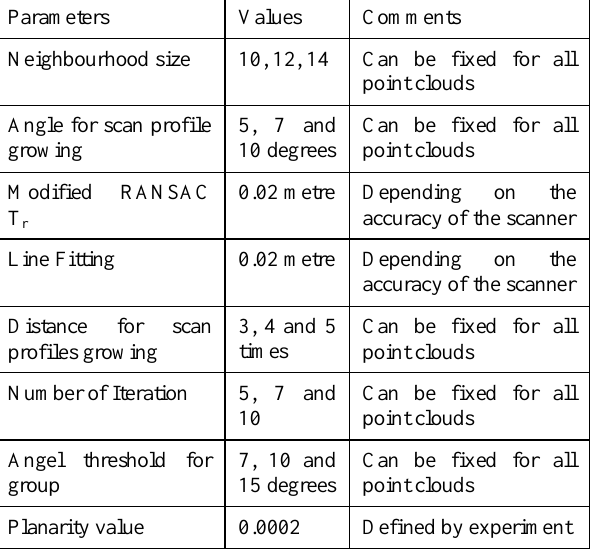
Table 2. Used Parameters for